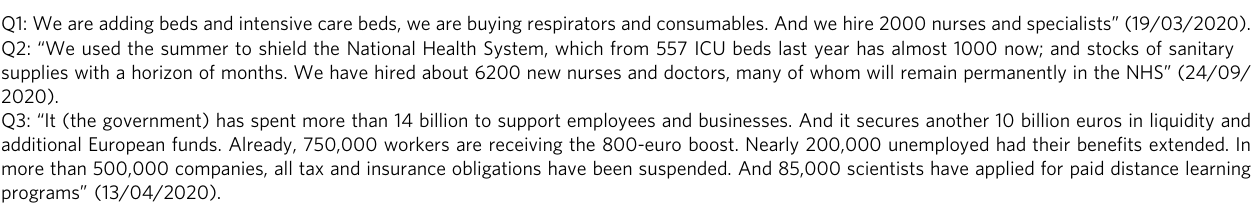
Table 5 Legitimization categories 3 .